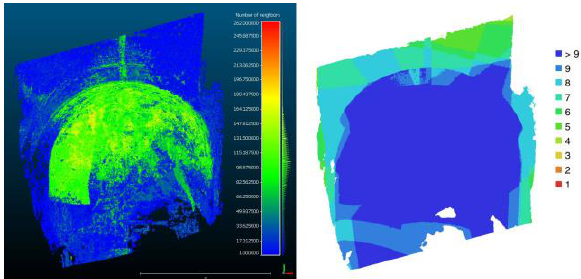
Figure 8. On the surface of the 3D mesh the high-resolution frame has been